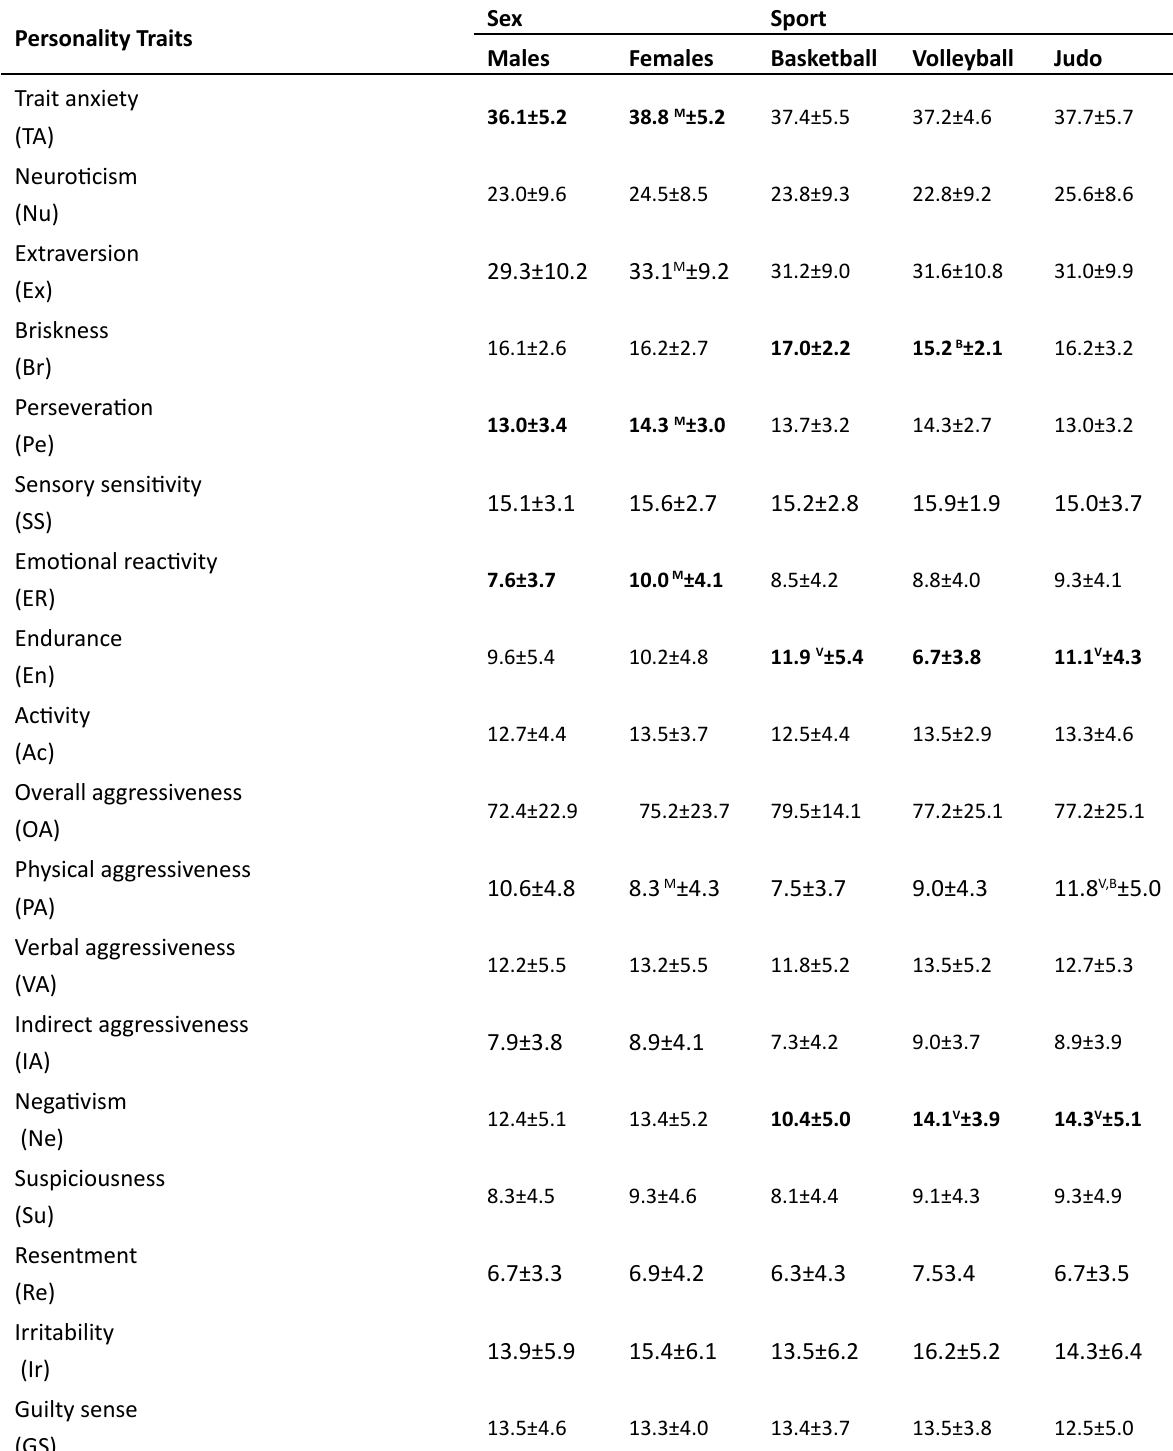
Sex Sport Males Females Basketball Volleyball Judo